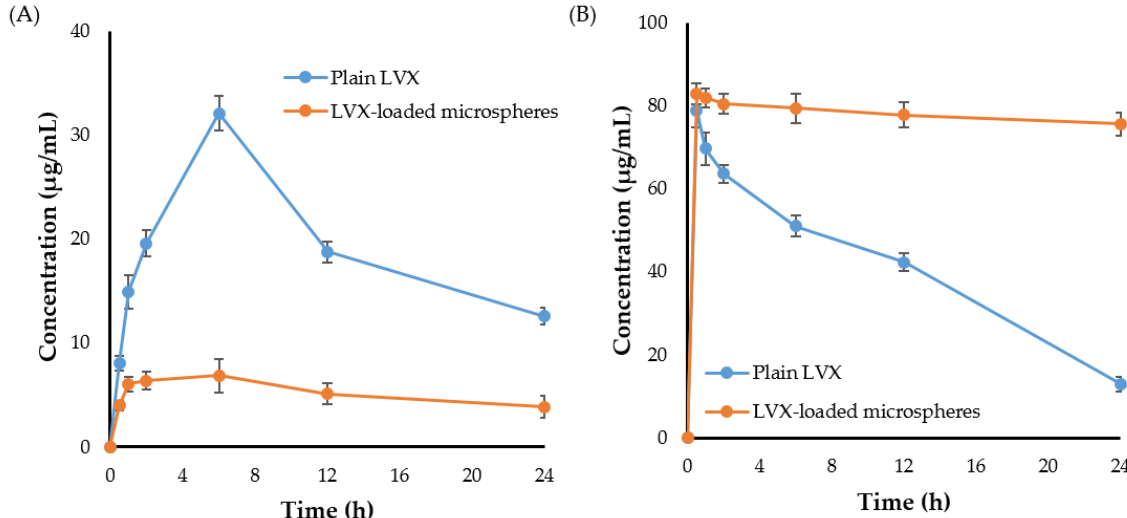
Figure 6. Mean drug concentration-time profile of plain LVX and LVX-loaded microspheres in ( A ) plasma and ( B ) lung following pulmonary inhalation.